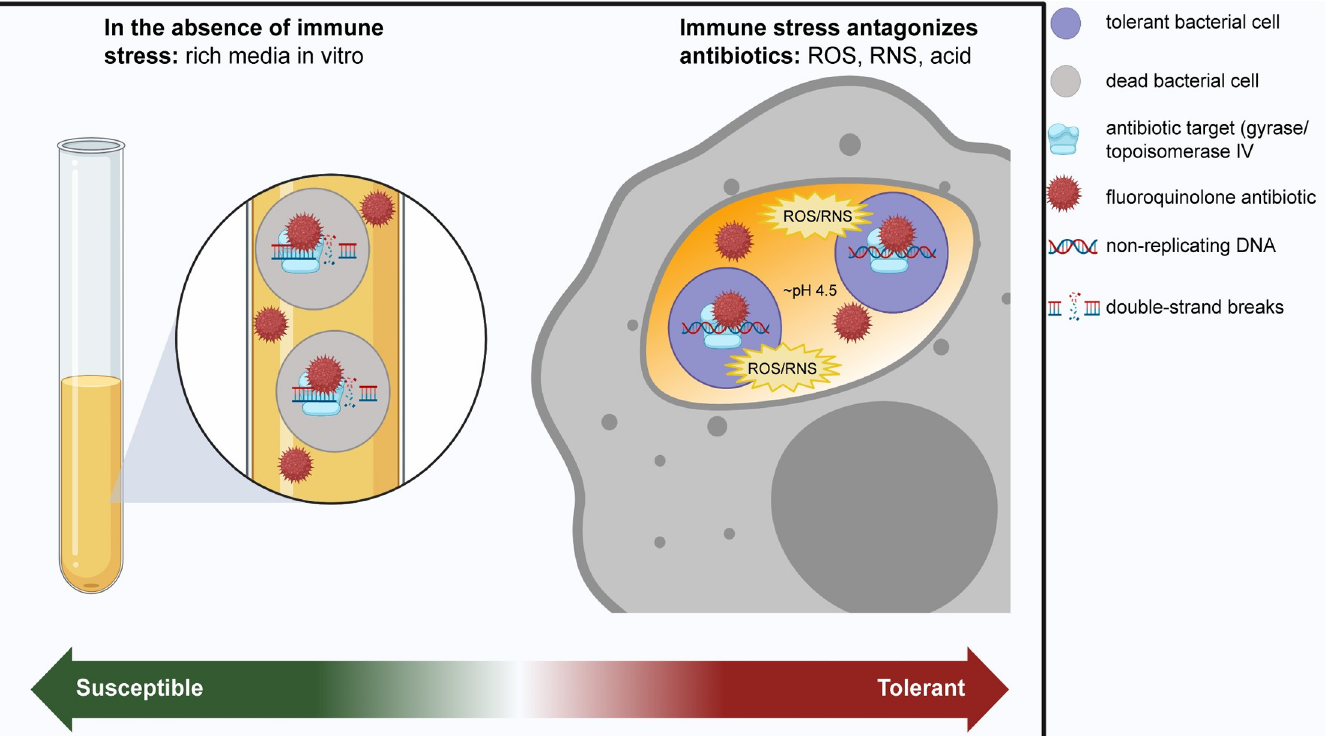
Fig 1. Bactericidal drugs may be static in vivo. In the absence of stress, when bacterial cells are undergoing replication, the bactericidal antibiotic fluoroquinolone binds to its target (DNA gyrase and topoisomerase IV) and prevents the religation step during DNA synthesis. This leads to double-strand breaks and cell death. Macrophage-produced stresses (such as ROS/RNS or acid stress) may down-regulate cellular processes targeted by antibiotics. In the absence of replication, the fluoroquinolone may bind to its target but does not cause double-strand breaks or cell death. This leads to antibiotic tolerance. Figure created using BioRender. R AU : AnabbreviationlisthasbeencompiledforthoseusedthroughoutFig 1 : Pleaseverifythattheentryiscorrect : OS/ RNS, reactive oxygen and nitrogen